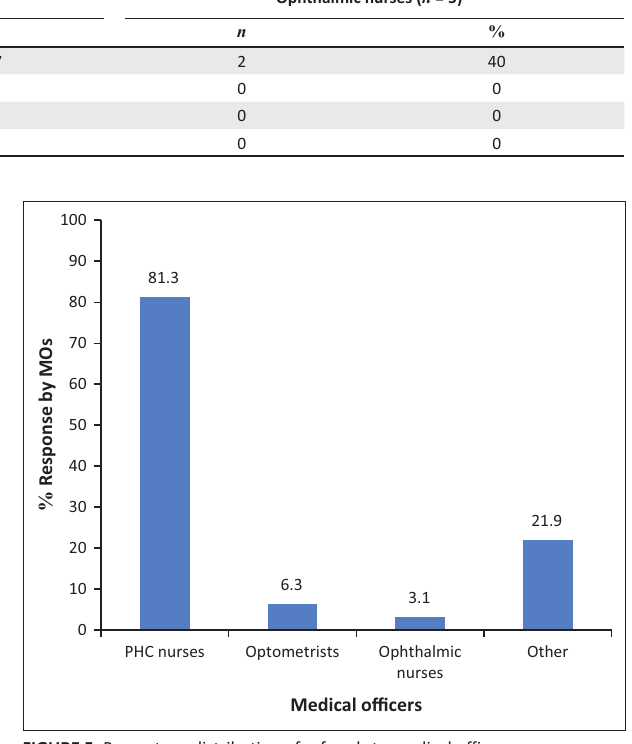
FIGURE 5: Percentage distribution of referrals to medical